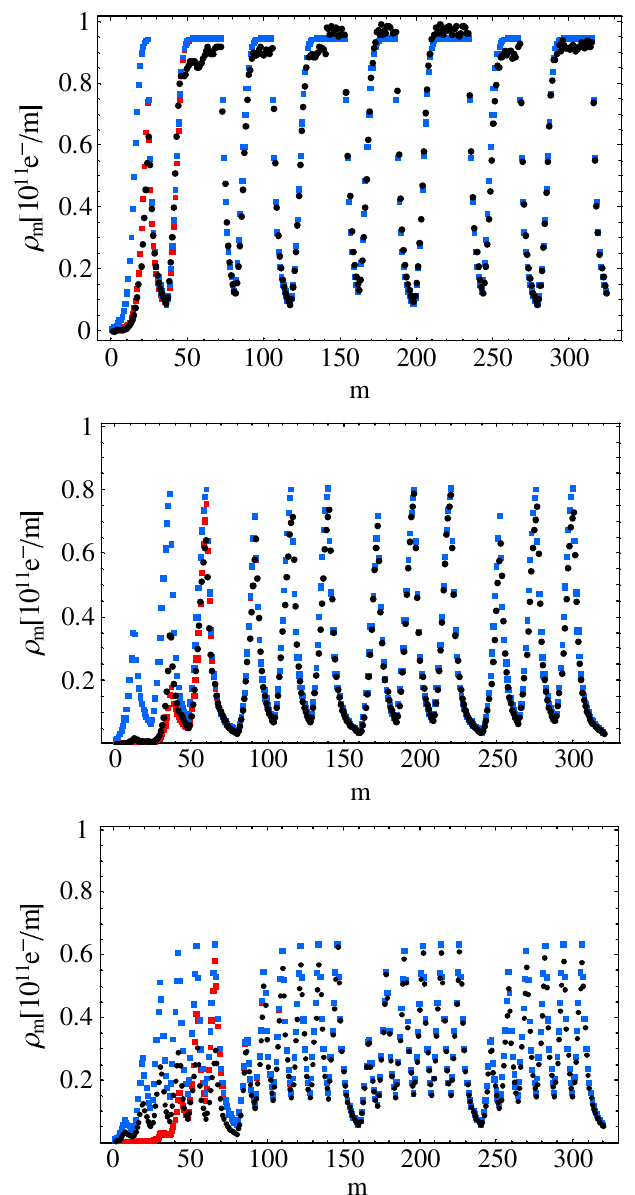
FIG. 5. (Color) Average e-cloud density evolution for three different bunch-train filling patterns, for N (cid:5) 1 : 2 (cid:3) 10 11 and (cid:5) 1 : 7 . Top: 24 f (cid:2) 12 e (cid:2) 36 f ; mid: 3 (cid:3) (cid:6) 12 f (cid:2) 12 e (cid:7) ; bot- (cid:1) max tom: 6 (cid:3) (cid:6) 6 f (cid:2) 6 e (cid:7) . In both cases, successive bunch trains are separated by gaps whose length corresponds to 28 (empty) bunches. Black markers: ECLOUD results. Blue and red markers: map results corresponding to initial electron densities (cid:2) (cid:5) 10 7 (cid:8) e (cid:2) =m (cid:9) , and (cid:2) 0